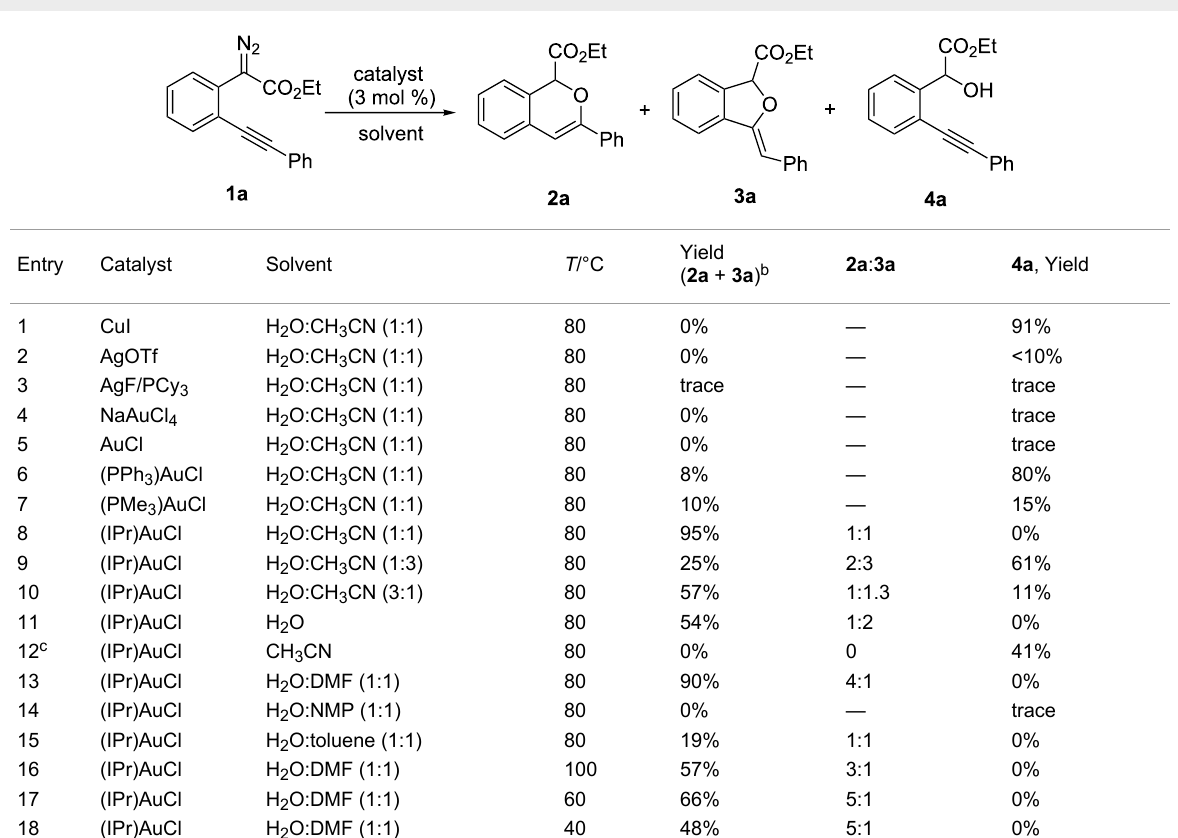
Table 1: Optimization of reaction conditions with phenyldiazoacetate 1a a